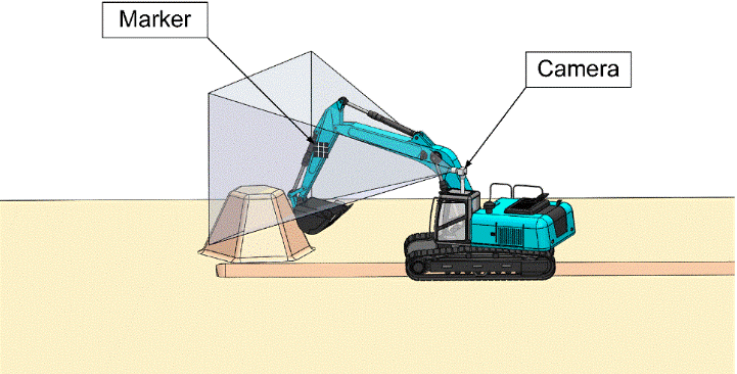
Figure 5. The camera is attached to the excavator cab.